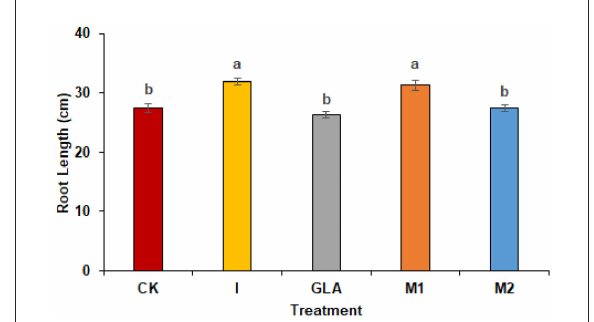
FIGURE6 Root length of radish observed in experiment 2 using chemical fertilizer (CK), Isabion ® (I), glycine + lysine + aspartic acid (GLA), moringa leaf extract + GLA (M1), 25% NPK + M1 (M2). The values mentioned herein are indicated as mean ± S.D and the lowercase letters indicate the significant difference among the